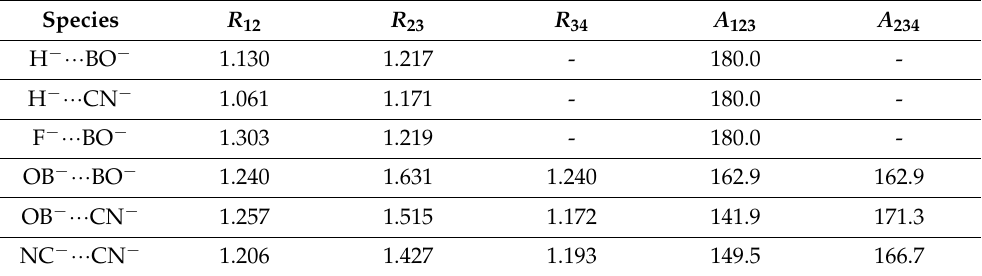
Table 1. Optimized geometrical parameters [interatomic distances R ij (Å), angles A ijk ( ◦ )] for equilib- rium species of Figure